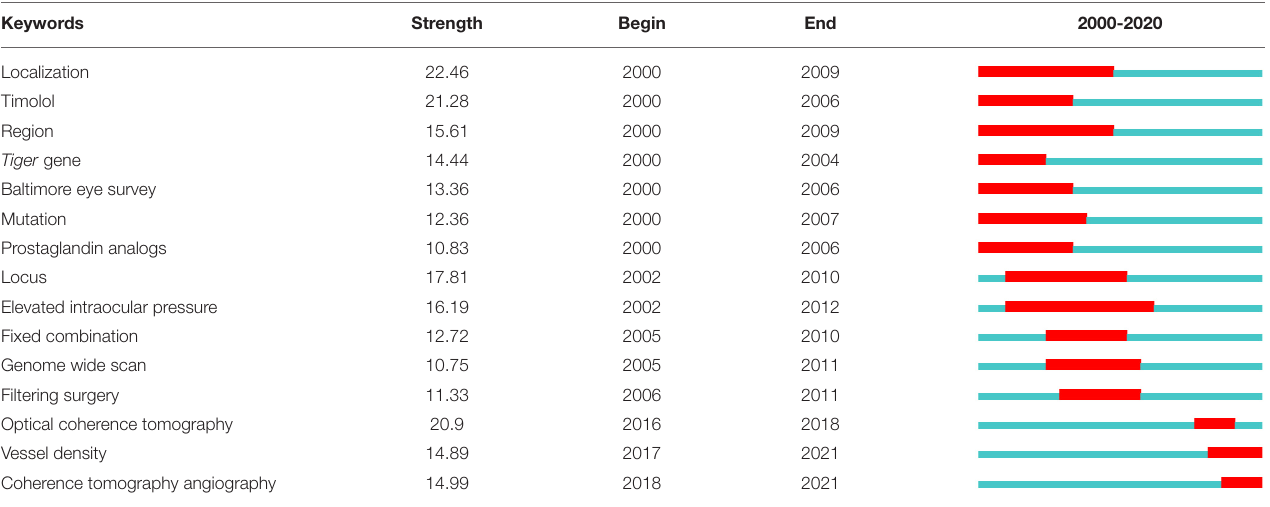
TABLE 6 | The top keywords with the strongest citation